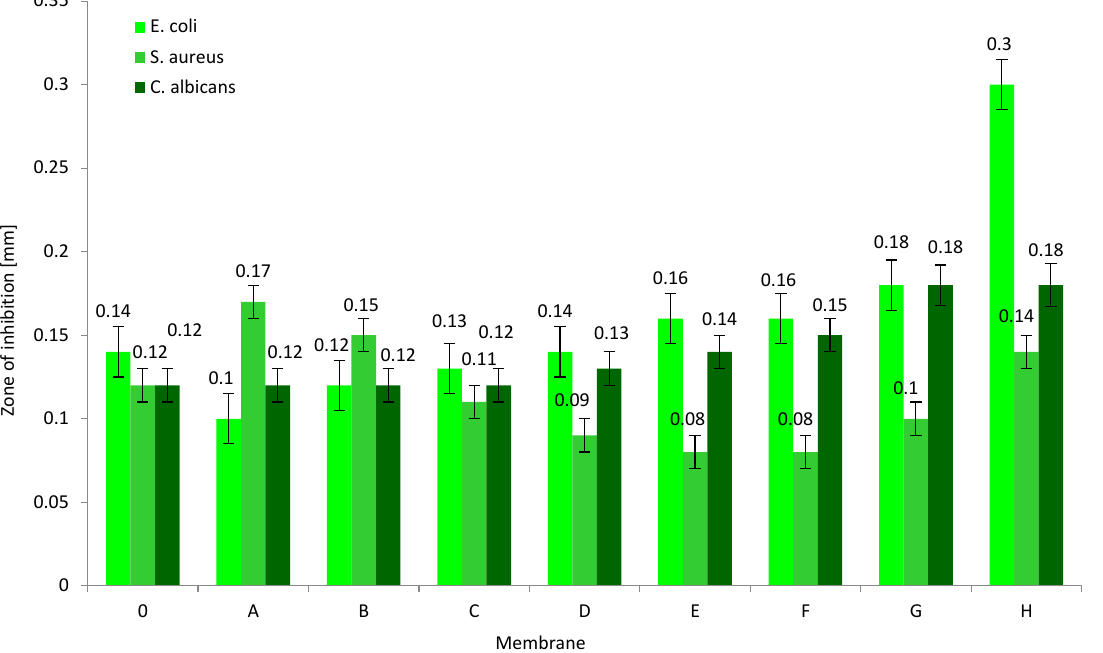
Figure 7. Zones of microorganism growth inhibition in the presence of pure PAN membranes (membrane 0) and rGO / PAN membranes (membranes A–H).